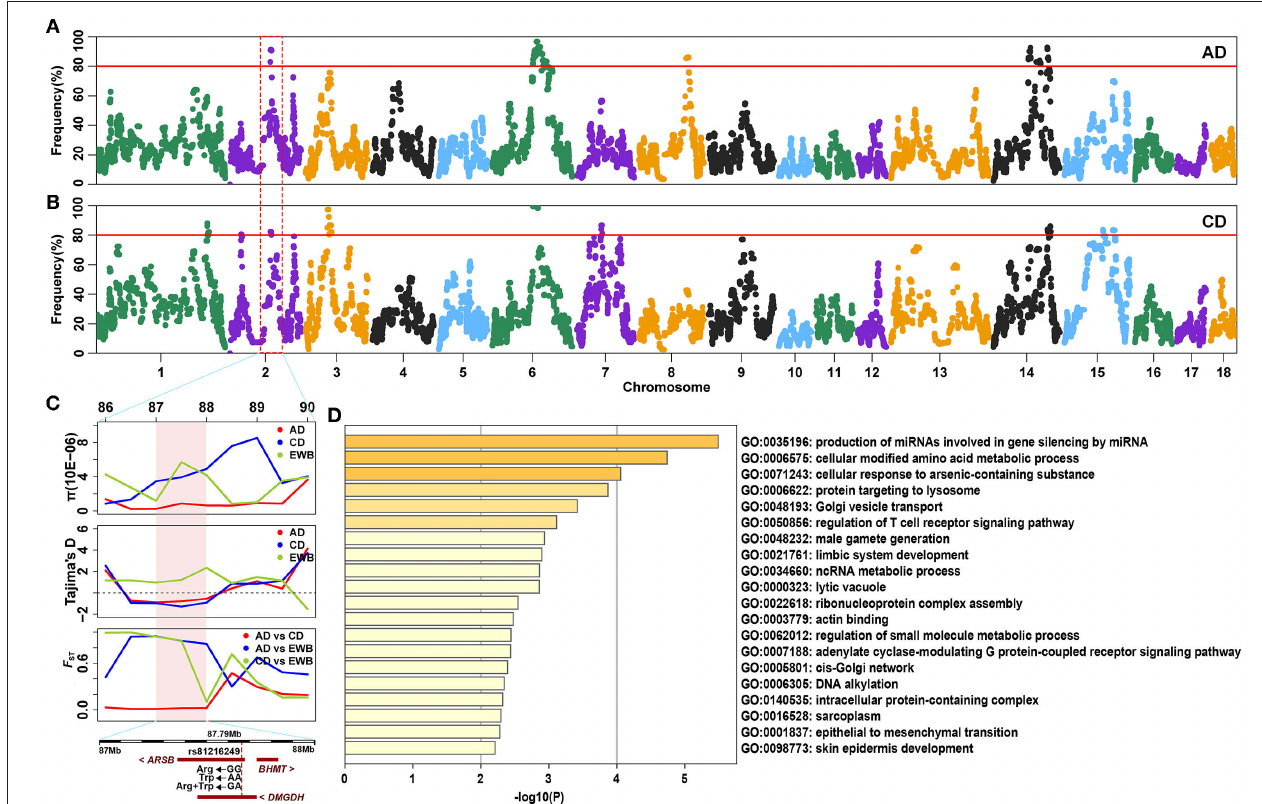
FIGURE 3 | Detection of ROH hotspots in two Duroc lines. (A,B) Manhattan plot of the occurrence (%) of each SNP in ROHs of AD and CD pigs, respectively. The red lines correspond to the significance threshold (80%). (C) The identical ROH region (SSC2: 87.00–88.00 Mb) was detected by π , Tajima’s D , and F ST methods in AD and CD pigs. The significant region is colored by a pink background. (D) Top 20 significant Gene Ontology (GO) terms of overlapping genes identified by